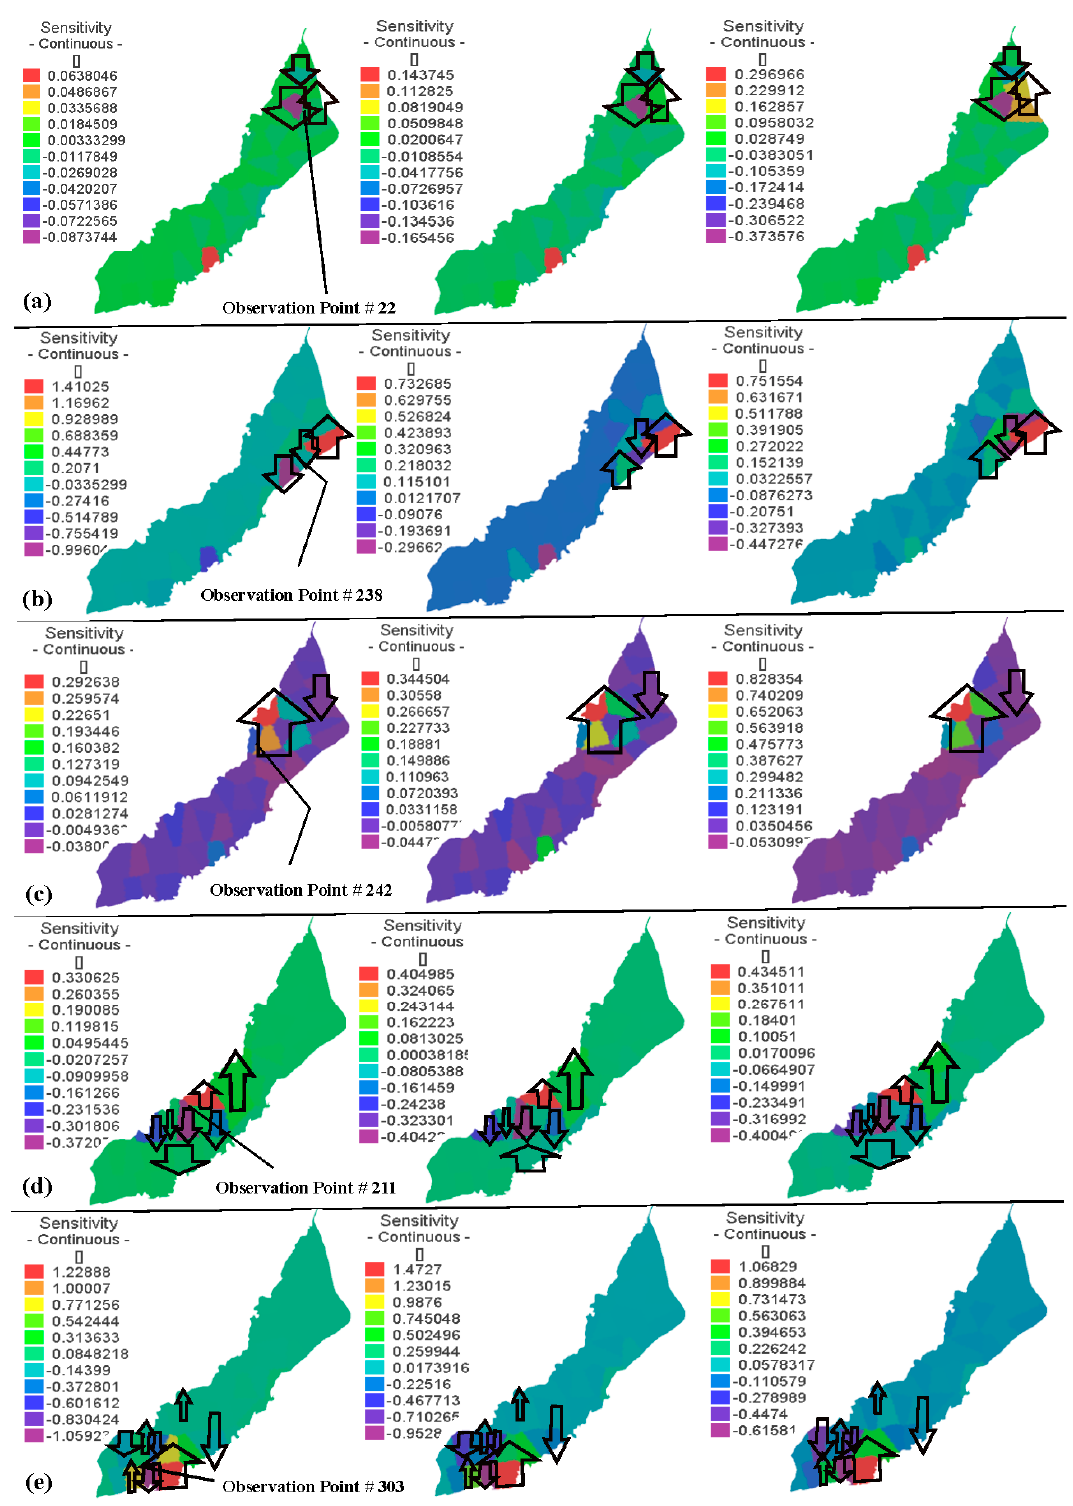
Figure 12. Distribution of observation sensitivity for selected piezometric points (( a ) piezometer # 22 in layer 1; ( b ) piezometers # 238 in layer 2; ( c ) piezometer # 242 in layer 2; ( d ) piezometer # 211 in layer 2 ( e ) piezometer # 303 in layer 3) in rabi 2006, kharif 2009 and kharif 2011. Note that the upper and lower arrowheads indicate increase and a decrease in sensitivity.